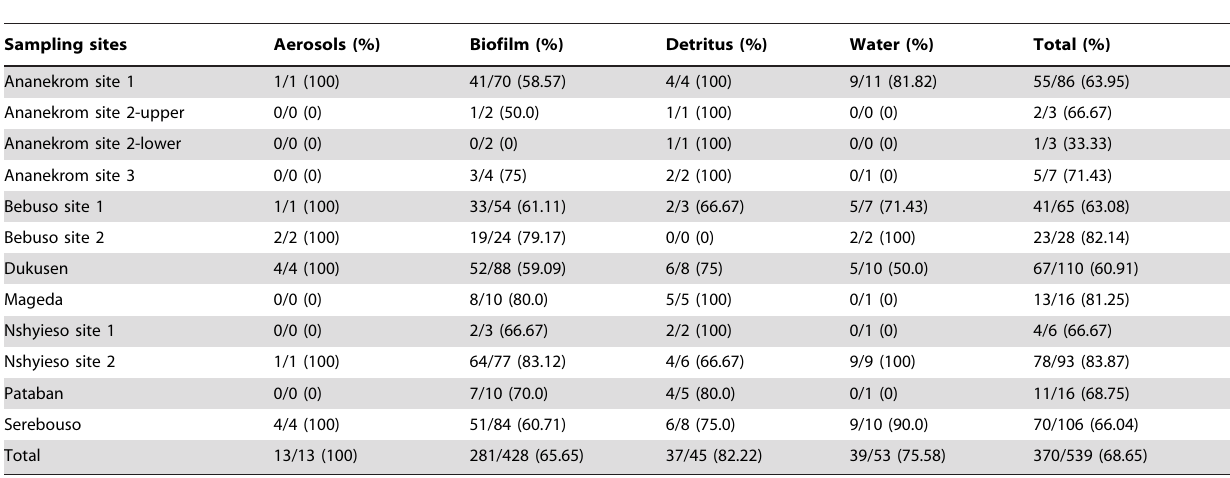
Table 2. Isolation of FLA per type of specimen and sampling